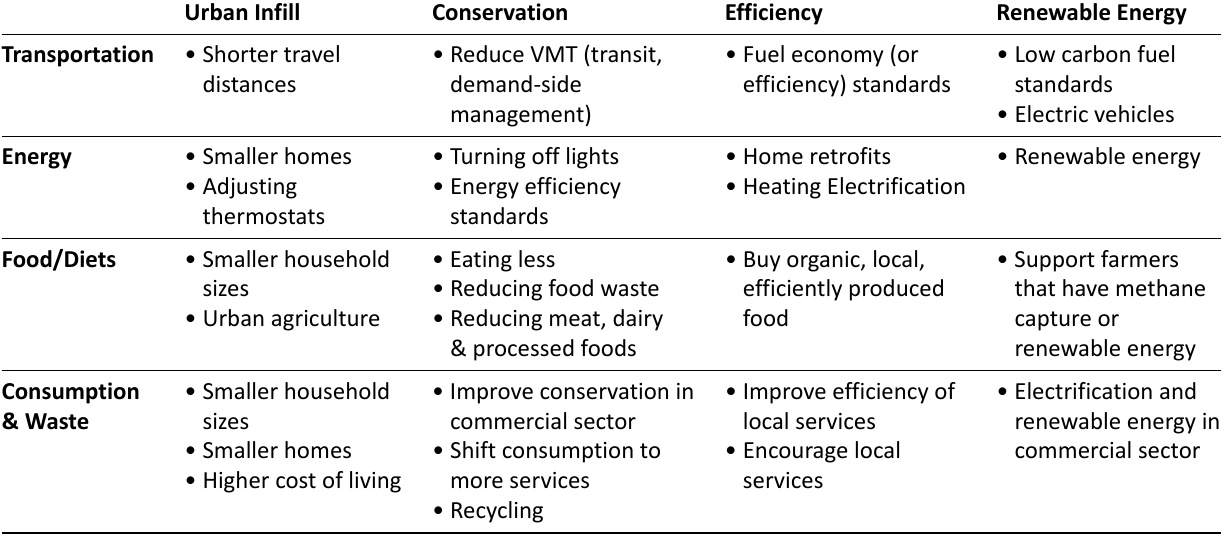
Table 2. Climate policy intervention areas by major category of household carbon